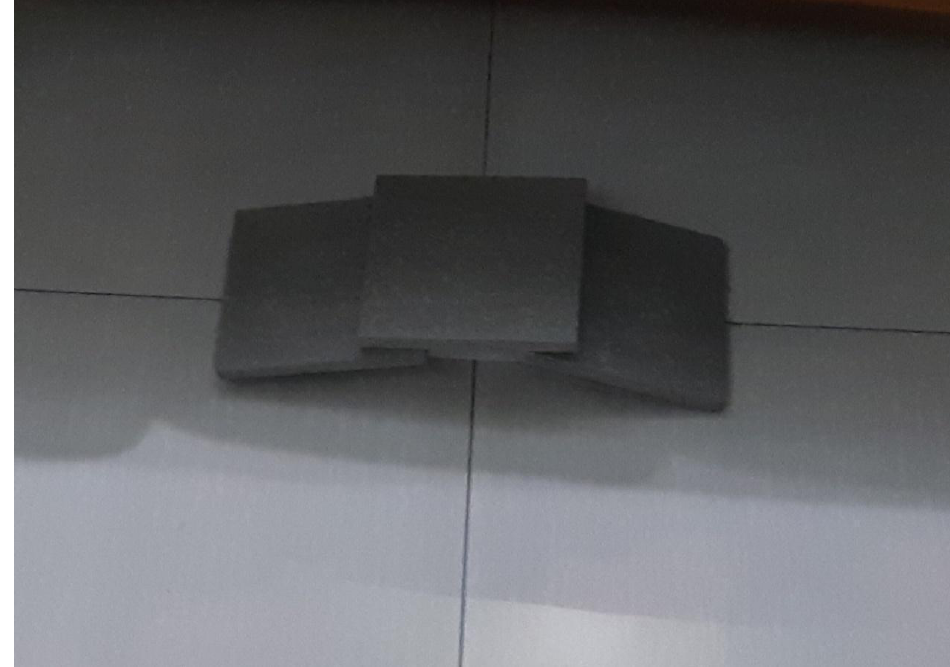
Figure 7. The experimental set of shielded signals by tiles. After the calculation, the possible positions of the trapped persons under different shielding conditions were obtained. The following figures denote various combinations; the red, blue, and green circles are the three observation points (0, 0, 1), (2.4, 0, 1), and (2.4, 2.4, 1). Figure 8 shows the testing result without any source signal breakage. The estimated error is around 4.5 m to 2.4 m. The results of the source signals blocked by wood are illustrated in Figure 9; the estimated locating error is about 5.1 to 2 m in this case. Figure 10 denotes that tiles have blocked the source signals, and the estimated locating error is also around 2.9 to 2.4 m. Therefore, it is evident that the system can indeed exert the ability of rapid search and rescue within a feasible range—an alternative to conducting a ground-based search at a disaster site. The results were acquired while the observation points were not evenly spread around the target. If improved observation geometry could be evenly distributed, then the accuracy of locating is around 1 m.